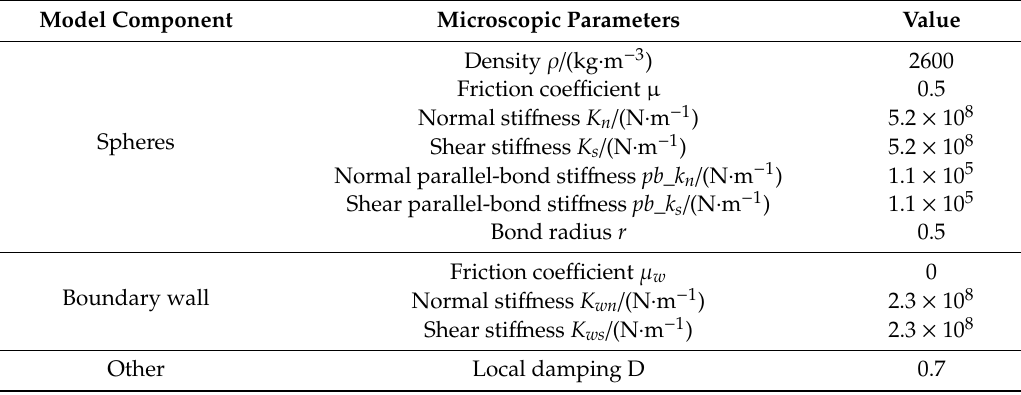
Table 4. Microscopic parameters for contact of the skeleton model.